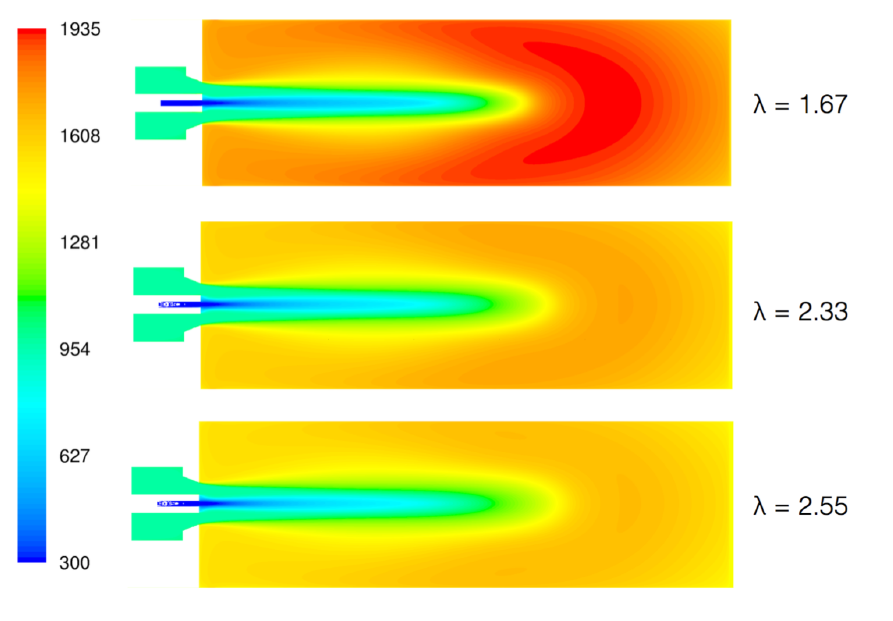
Figure 22. Temperature distribution (K) inside the combustion chamber, for different values of air-fuel equivalence ratios. Air inlet temperature 700 ◦ C. EDC-GRI3.0 numerical model.